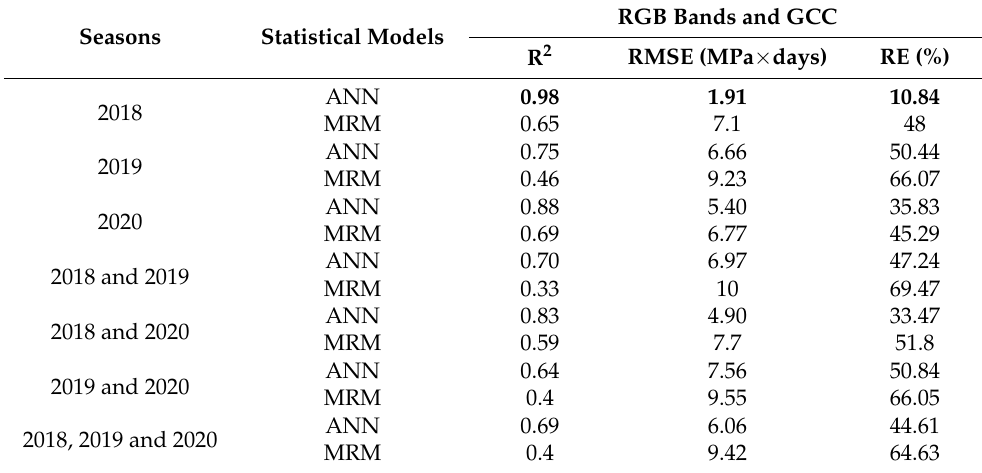
Table 4. Validation results (R 2 : determination coefficient, RMSE: root mean squared error, and RE: relative error) for the ANN regression models and MRM using normalised RGB bands and GCC to simulate the S ψ for every studied season in a vineyard cv. Monastrell, located in south-eastern Spain. Statistical values shown in bold indicate the best-performing